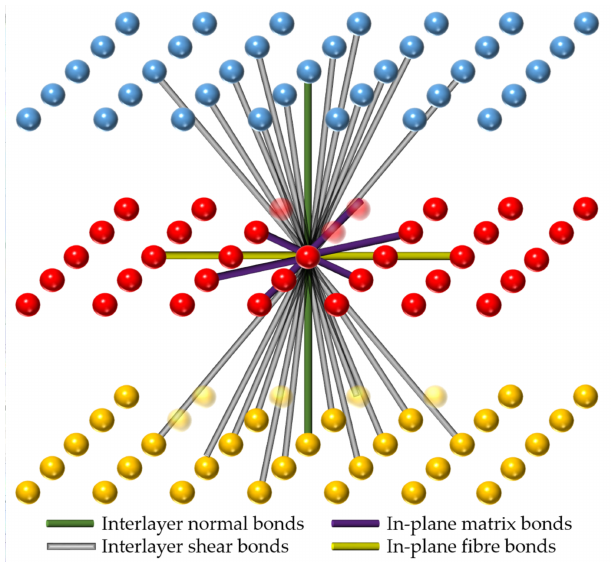
Figure 2. Illustration of PD laminate model for δ = 2 ∆ x and fibre direction, Φ =